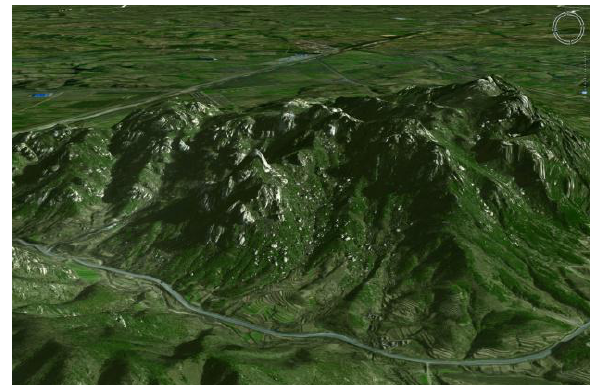
Figure 6. Wulianshan peak forest landform